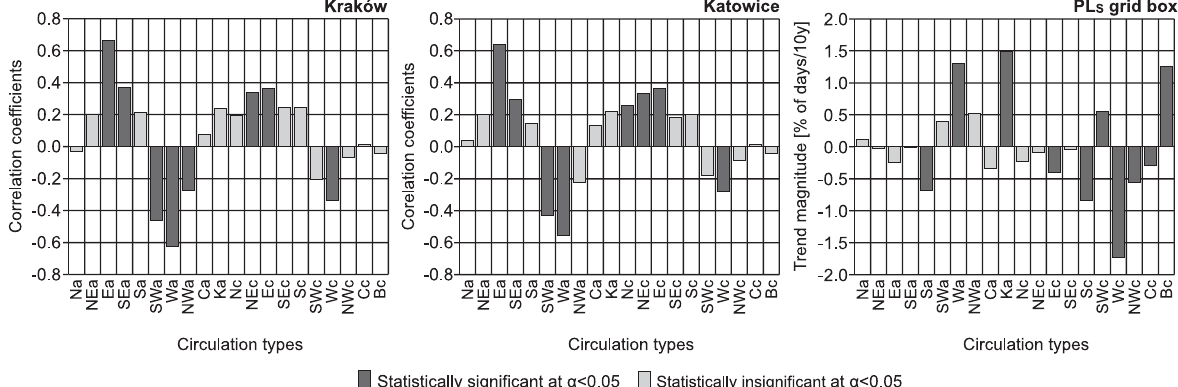
Fig. 5. Correlation coefficients between the ice days frequency (Kraków and Katowice) and the frequency of circulation types for PL grid box and linear trends in the frequency of circulation types for PL S